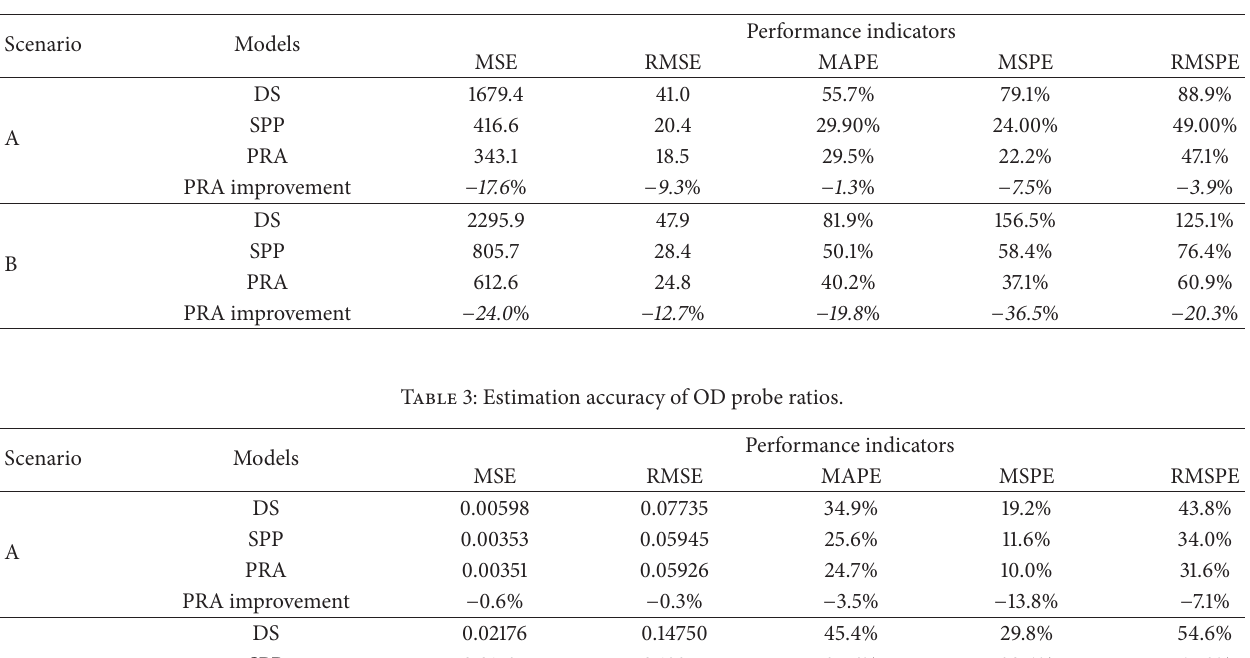
Table 2: Estimation accuracy of OD flows.